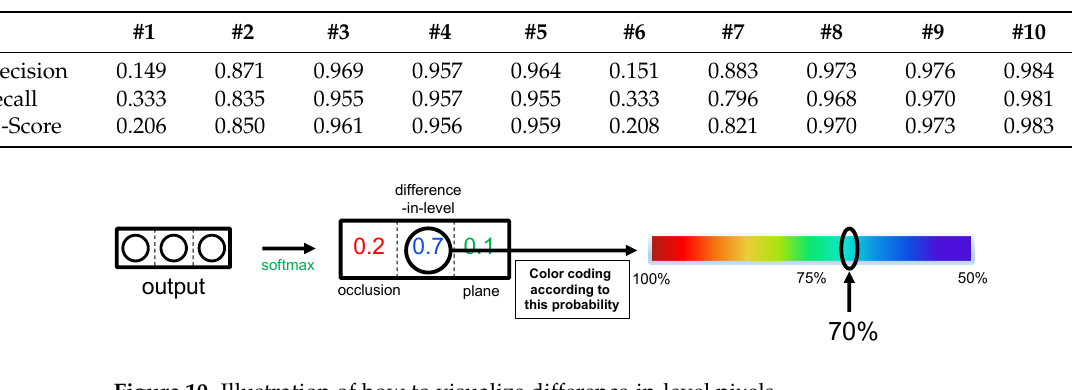
Figure 10. Illustration of how to visualize difference-in-level